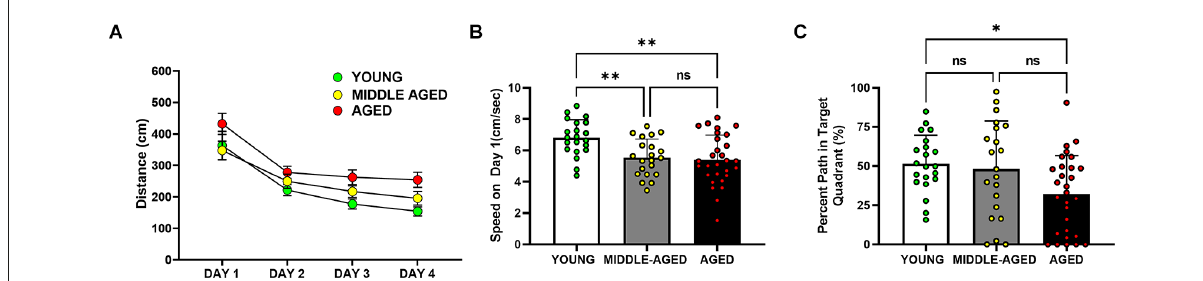
FIGURE2 Cognitive performance of aged mice (18–22 months) is impaired in the Barnes maze, but not in middle-aged mice (13–14 months) relative to the young cohort (4–6 months). (A) Analysis of the distance traveled by mice to locate the escape box. Aged mice showed longer distance traveled to the escape than young and middle-aged mice ( ∗ ), such that distance traveled in young and middle-aged mice was significantly decreased in comparison with the values observed in aged mice ( ∗ , post hoc Tukey/Kramer, p < 0.05). (B) Speed on the first day of Barnes performance, pre training. Young mice moved faster than the middle-aged and aged cohorts ( ∗∗ , post hoc Tukey’s multiple comparison, p < 0.01; middle-aged vs. aged, ns = non-significant, p > 0.05). (C) Percent of the path localized in the target quadrant (i.e., quadrant in which the escape was localized during training trials, during the first 30 s of the trial). Only the young and aged groups are marked by significant differences ( ∗ , Tukey’s multiple comparison; p < 0.05). In (B) and (C) , bars depict Mean ± SEM values of the corresponding age group. Circles indicate individual scores of each mouse.